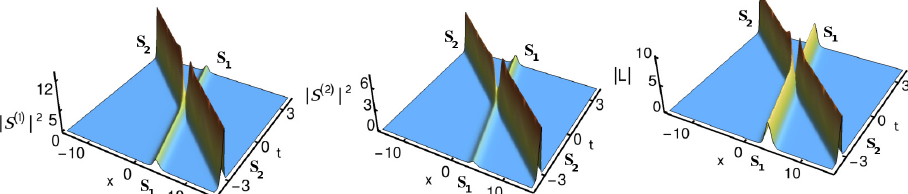
Figure 16. Energy sharing collision among the degenerate solitons in a 2-component LSRI system. The parameter values are k 1 = 1.5 − 0.5 i , k 2 = 2 − 2 i , α